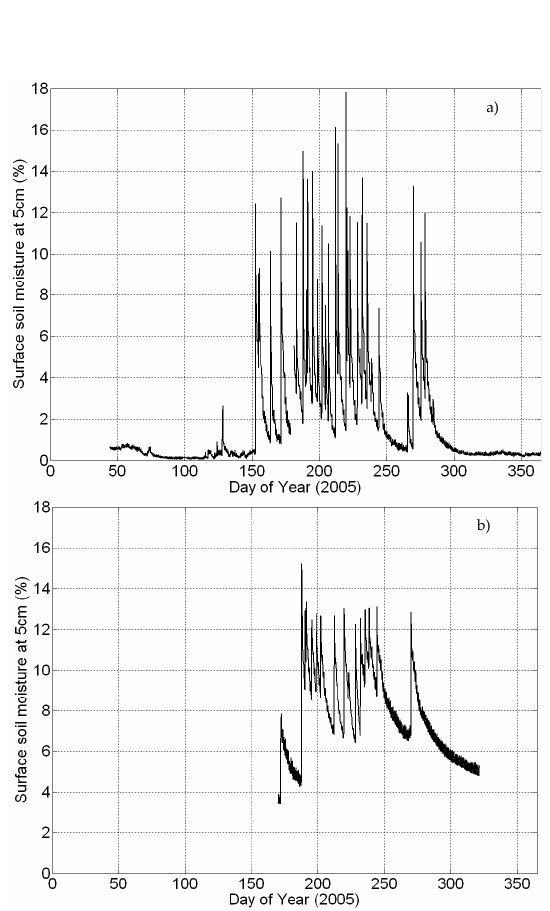
Fig. 3. Seasonal variation of surface soil moisture (SSM) at 5cm depth at the Agoufou sandy (a) and Eguerit rocky (b) sites in 2005.